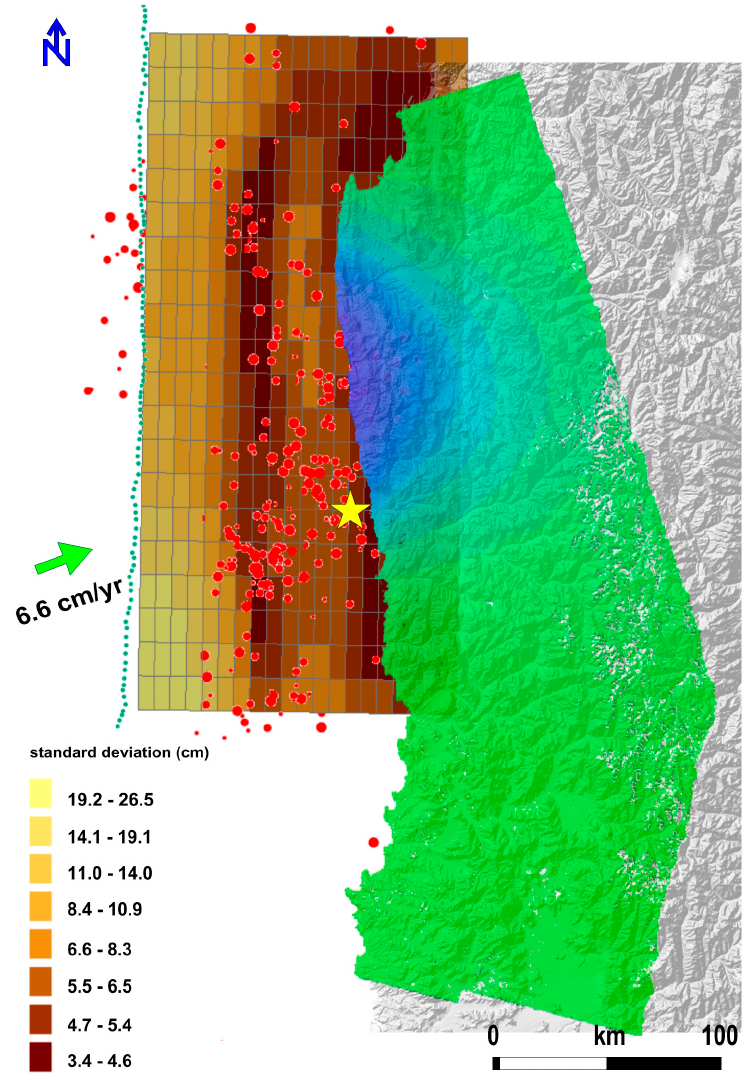
Figure A2. Standard deviation associated to the slip values of Figure 5a. The aftershock distribution, with M > 4, spanning from 16 September (main shock) to 19 September (corresponding to the last day of temporal coverage of satellite data) are depicted with red circles. The yellow star is the main shock epicenter.